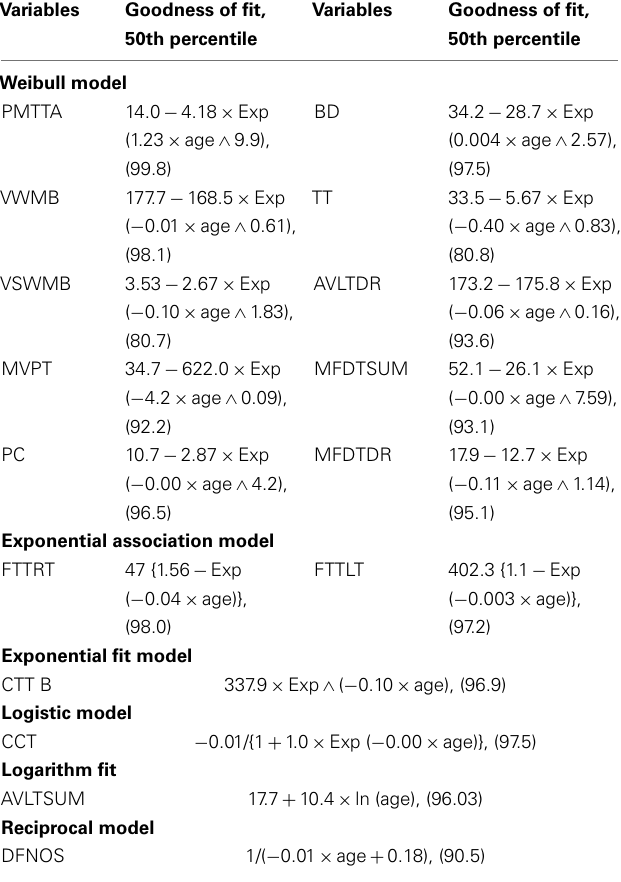
Table 2 | Goodness of fit for the variables that followed different growth